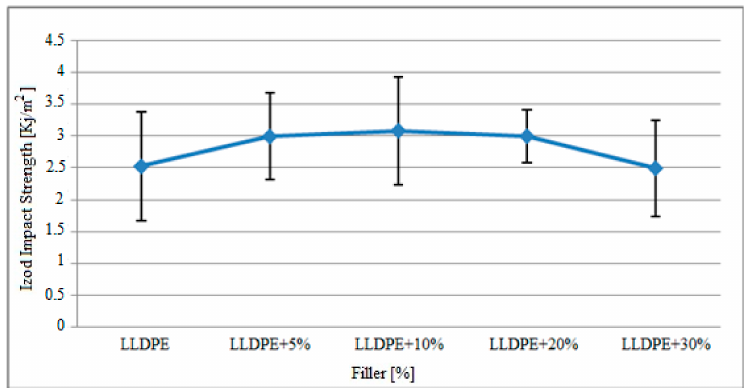
Figure 9. Variation in Izod impact strength of the polyethylene matrix specimens after gamma radiation.